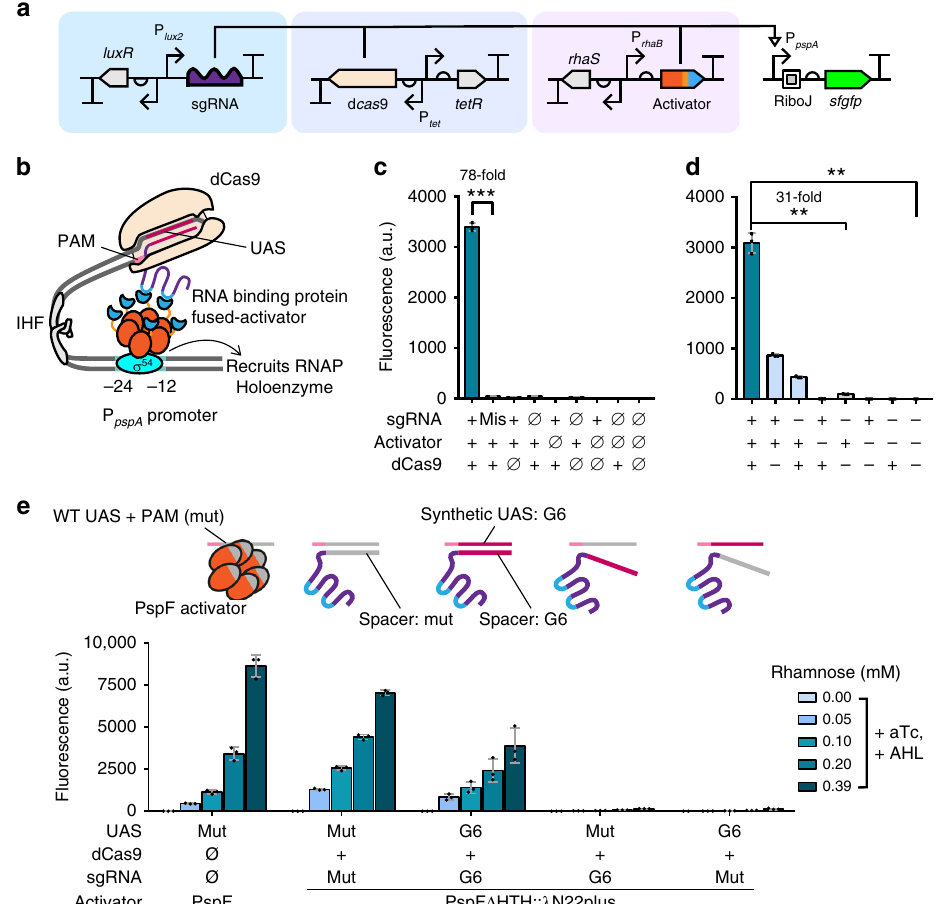
Fig. 1 Design and function of eukaryote-like CRISPR activation in E. coli . a The circuit design and structure of the CRISPRa device. The circuit includes a sgRNA generator driven by P lux2 (light blue block, inducible by AHL), a dCas9 generator driven by P tet (blue block, inducible by aTc), an activator generator driven by P rhaB (red block, inducible by rhamnose), and a sfGFP reporter driven by P pspA with wild-type or heterologous UAS. b The activation mechanism of a eukaryote-like long distance regulation in our CRISPRa design, based on the IHF-dependent DNA loop structure. c , d Test of necessity of the three components in CRISPRa. c Combinations of components were achieved via presence ( + ) or absence (ø) of genetic part in the strain. The mismatch sgRNA had a random sequence as its spacer (sgRNA-LEA3). All strains were cultured with AHL (1.6 µ M), rhamnose (0.4 m M ) and aTc (2.5 ng mL − 1 ). Statistical difference was determined by a two-tailed Welch ’ s t-test: (sgRNA cognate/mismatch) p = 0.0002, t = 74.98. d All genetic components for CRISPRa were present in the strain and combinations were achieved via presence ( + ) or absence ( − ) of inducers. Inducer concentrations: AHL (1.6 µ M), rhamnose (0.4 m M ) and aTc (2.5 ng mL − 1 ). Statistical difference was determined by a two-tailed Welch ’ s t test: ( +++ / −−− ), p = 0.0014, t = 26.82, ( +++ / − + − ), p = 0.0015, t = 25.98. e A PAM inserted P pspA with wild-type UAS (referred as mut) or heterologous UAS (referred as G6) was tested against different spacers for activation in a pspF knocked out strain E. coli MC1061 Δ pspF . Concentrations of inducers: aTc (2.5 ng mL − 1 ), AHL (1.6 µ M). Error bars, s.d. ( n